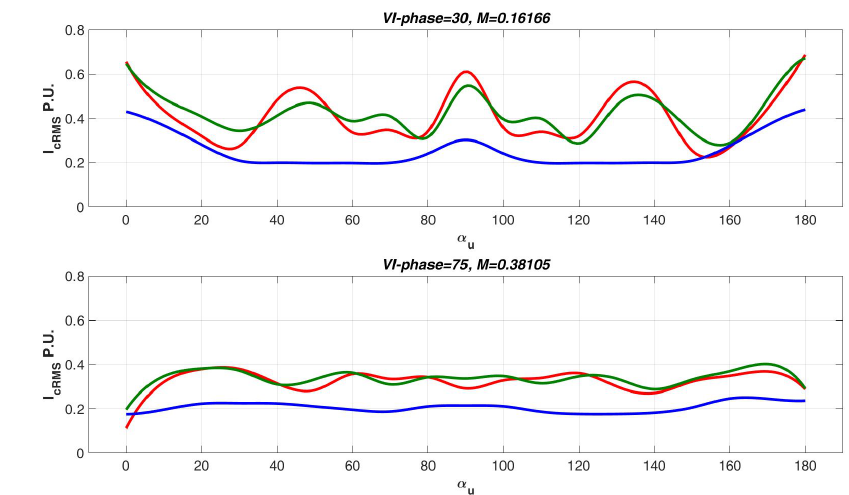
Figure 22. Each picture shows I C values for different α u and different couples of M and VI-phase. rms The blue line is the simulated I C for triple-3-phase converter in Figure 4, the green line is the rms simulated I C considering a model of the triple-3-phase converter used in the laboratory setup with rms estimated concentrated resonance parameters, and the red line is the measured evolution of I C the laboratory